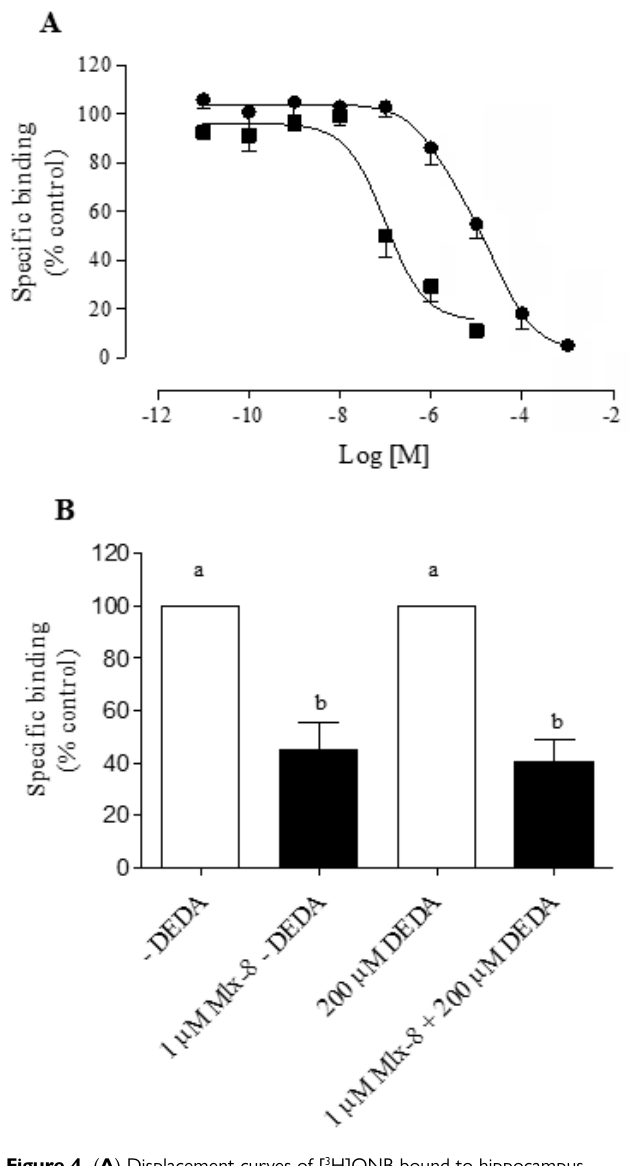
Figure 4. ( A ) Displacement curves of [ 3 H]QNB bound to hippocampus membranes from male rats induced by Mlx-8 toxin (  ) and muscarinic acetylcholine receptor antagonist pirezenpine (  ). ( B ) Displacement of [ 3 H] QNB bound to hippocampus membrane by 1 µM Mlx-8 toxin obtained from Micrurus lemniscatus venom in the absence and presence of 200 µM DEDA, an inhibitor of phospholipase A . The data are plotted as percentages of 2 the binding in the absence of Mlx-8 or muscarinic acetylcholine receptor antagonists. Each point and vertical line represents the mean ± S.E.M. of n = 4, performed in duplicate. Different letters indicate statistical significance (p < 0.05; ANOVA, Newman–Keuls